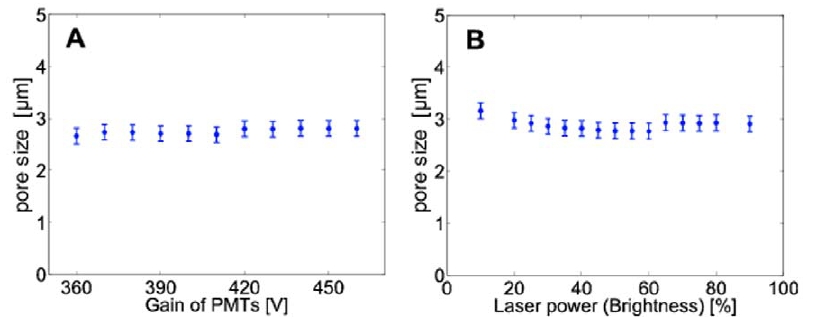
Figure 11. Insensitivity of the algorithm to variations in the input data quality. The algorithm produces stable results over a wide range of photomultiplier gain (A) and laser outlet power (B). Note that the data in (A) and (B) correspond to two collagen gels that have been fabricated under identical conditions. The slight differences in the observed pore sizes reflect sample-to-sample fluctuations.